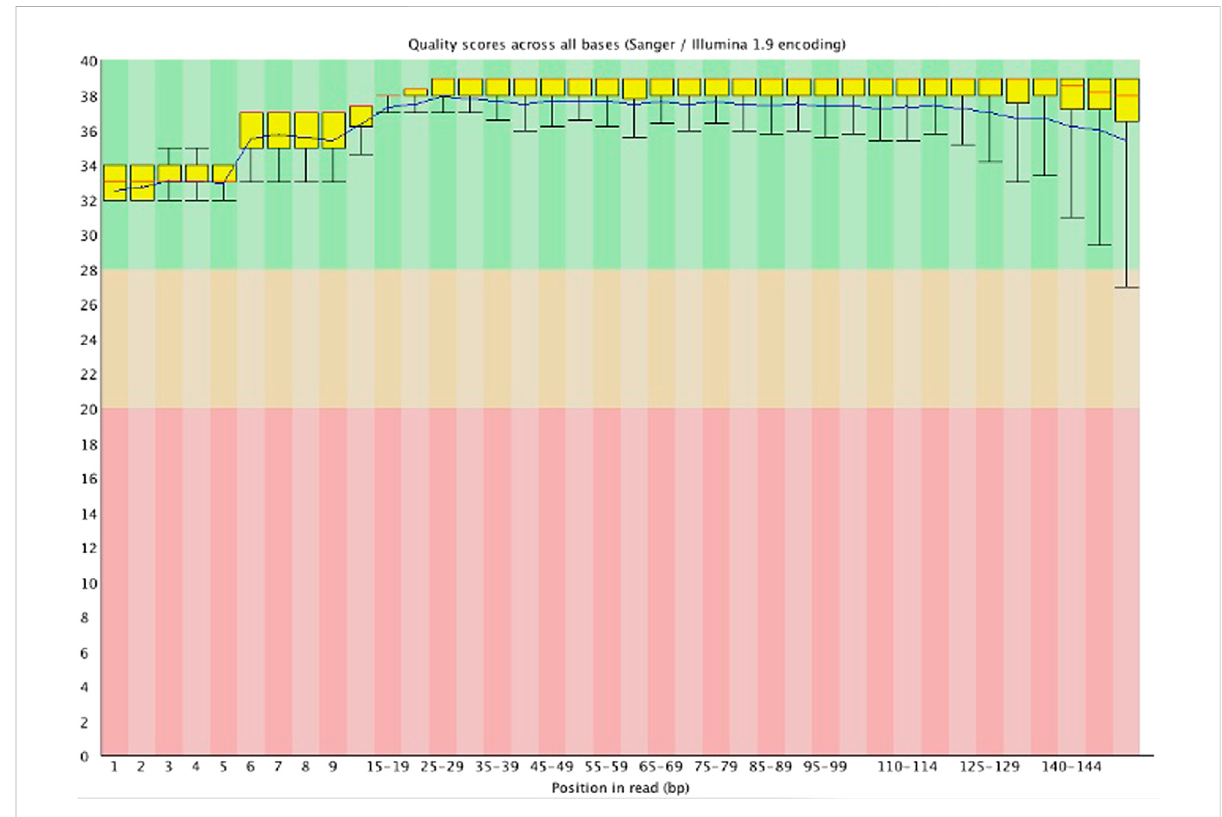
FIGURE 1 Per base sequence quality of “ 2016/083/mammae ” sample (Generated by FastQC